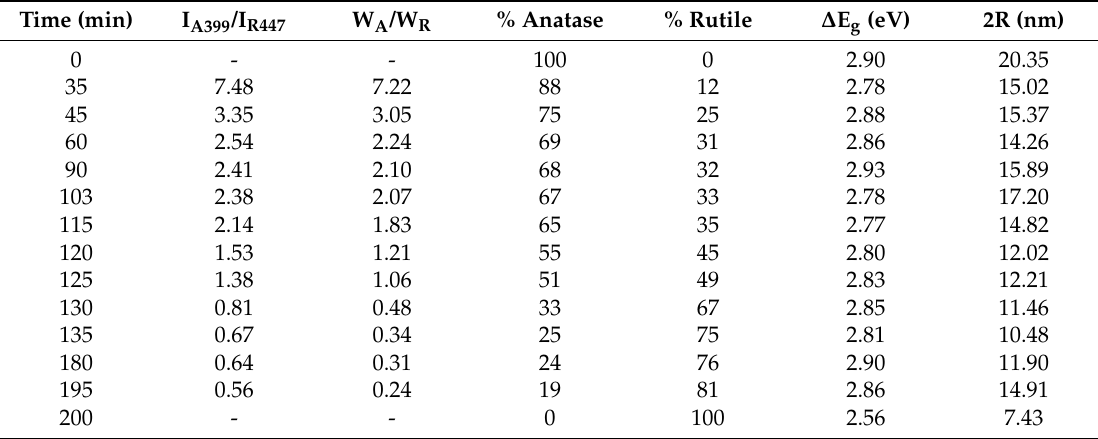
Table 1. Phase content, optical bandgap, and particle size as a function of the annealing time.